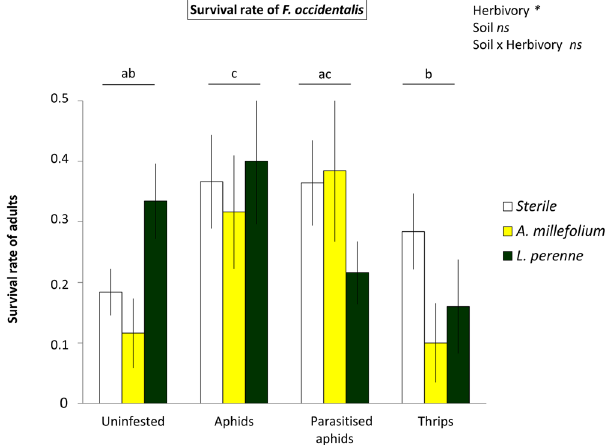
Figure 3. Performance of F. occidentalis , number that reach the adult stage (out of 5 initial individuals) on C. annuum for four different treatments: (a) uninfested plants, (b) aphid-infested plants, (c) parasitised aphid- infested plants, (d) thrips-infested plants, on three different soil types: (a) sterile soil, (b) A. millefolium , (c) L. perenne . Bars represent means ± SE (n = 12 replicates). Different letters indicate significant pairwise differences between infestation treatments (P < 0.05).